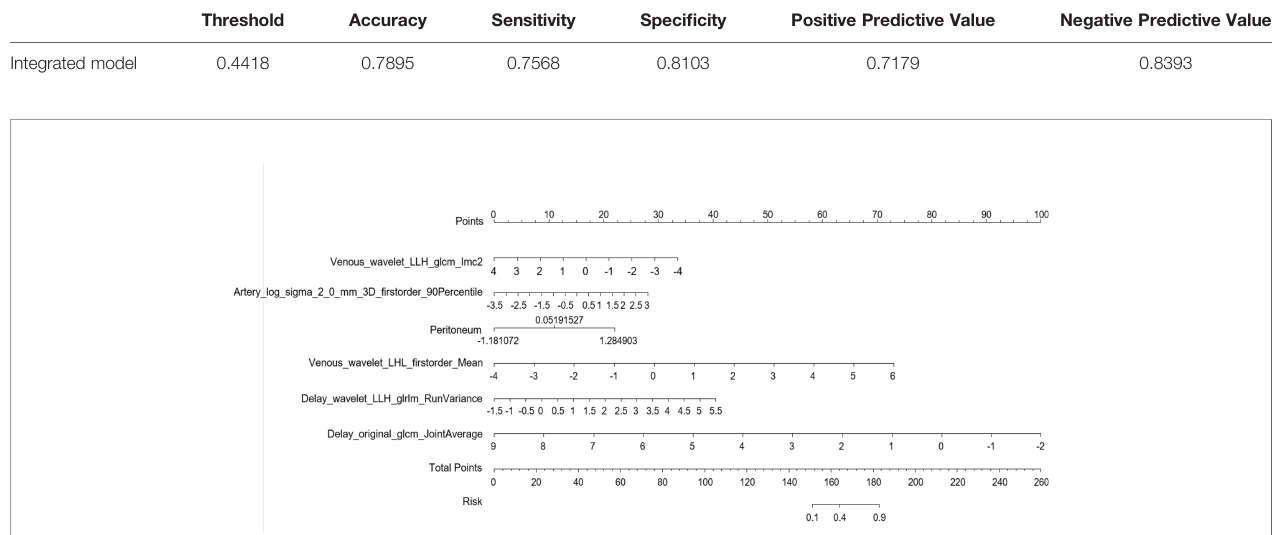
TABLE 5 | Diagnostic effectiveness of the integrated